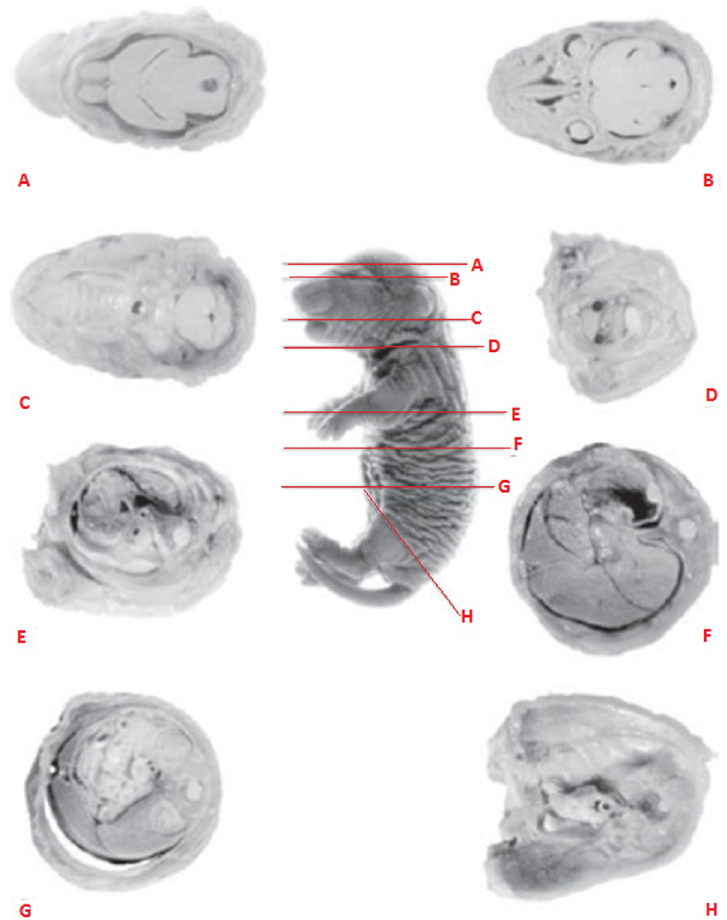
Fig 1. Transversal sections (A–H) of a 21-day-old male rat fetus (Bouin’s fixation, Wilson’s free-hand method, with own modification for the head examination [22].